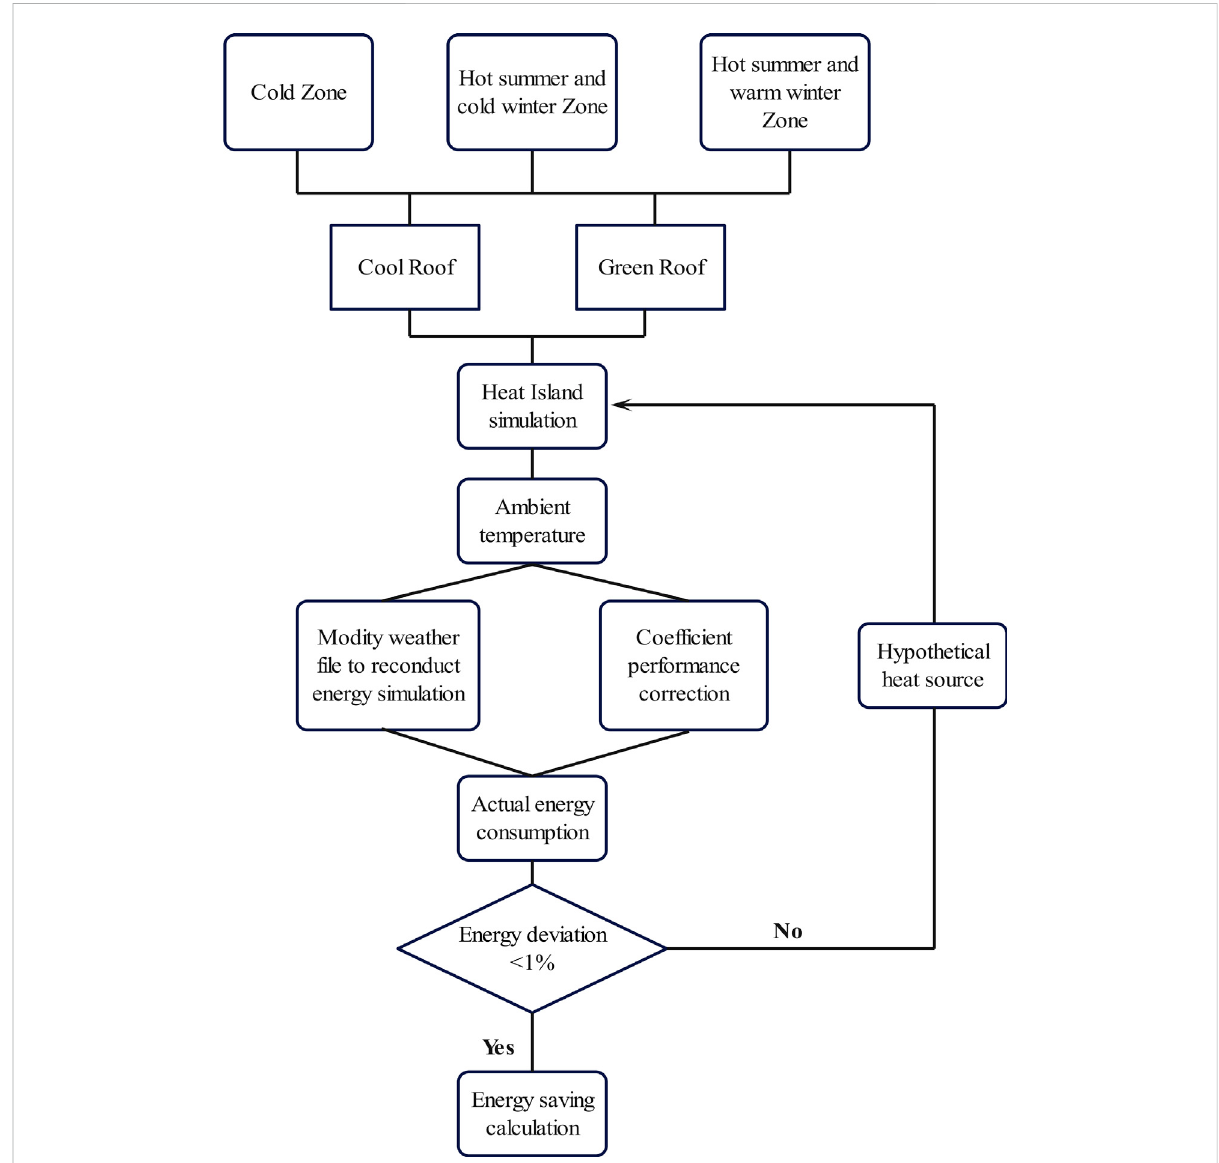
FIGURE 4 Analysis and calculation diagram of the triple energy consumption